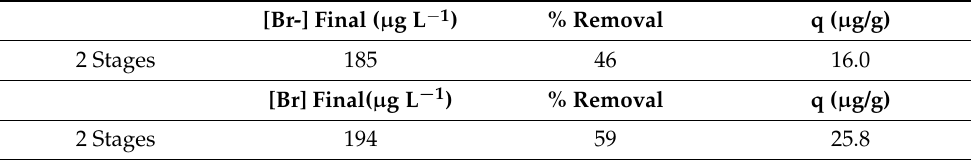
Table 5. Bromide concentration, bromine and percent removal and amount adsorbed by activated carbon in a two-stage experiment at the end of the